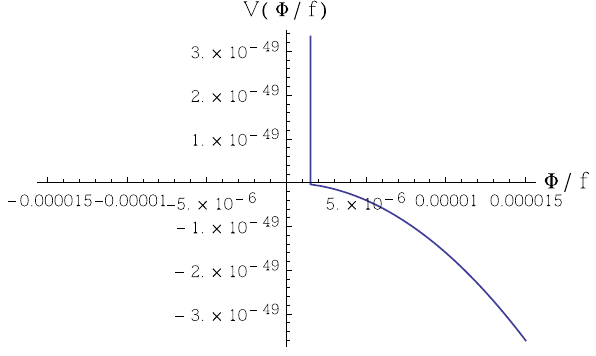
Fig. 3 Modular potential for the ADS brane for ω = 10 − 20